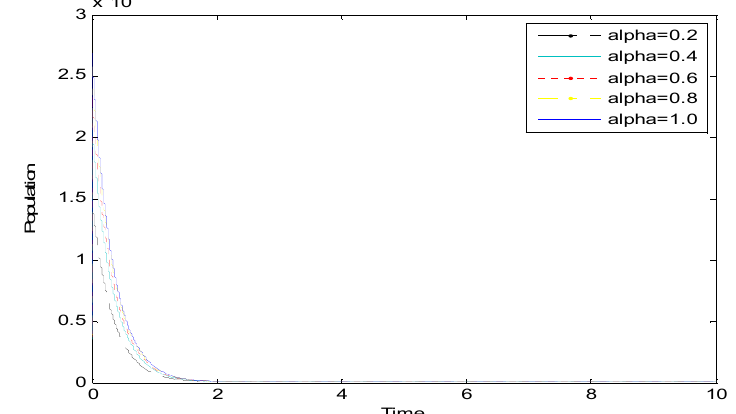
Figure 2. Dynamics of the infected population for various values of α .